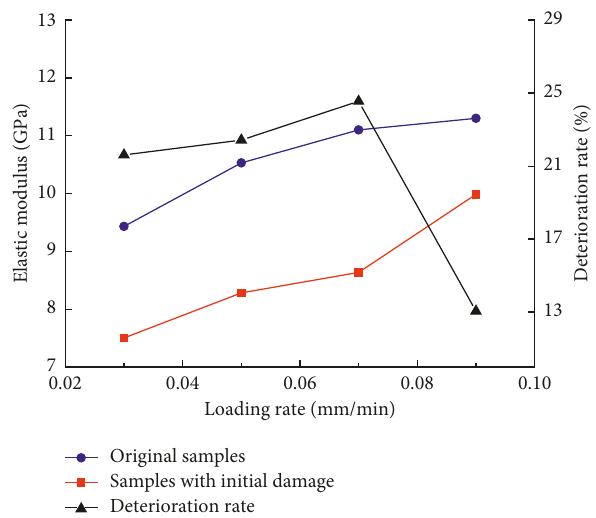
Figure 9: Change in the elastic modulus and deterioration rate depending on the loading